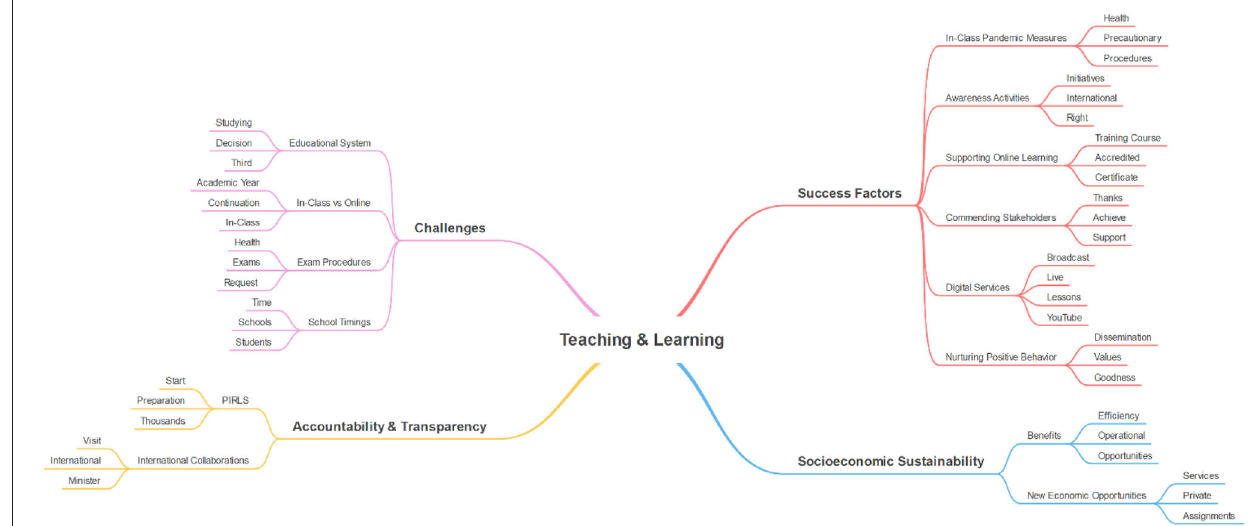
FIGURE 3 | Taxonomy of discovered urban governance parameters.